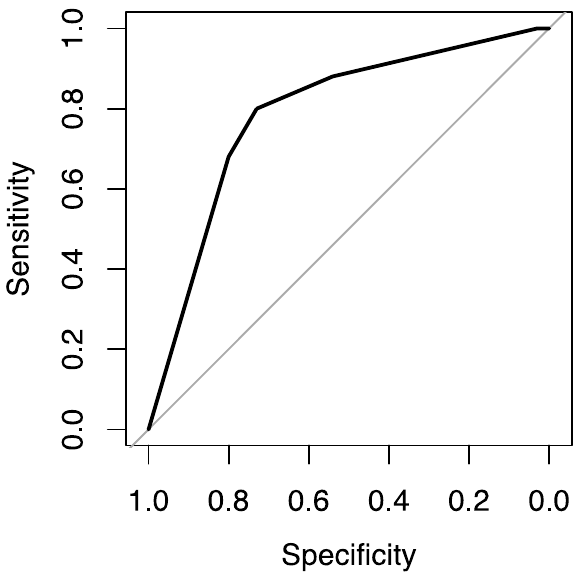
Figure 6. ROC curve showing the F7 parameter’s potentiality in the IDH prediction.